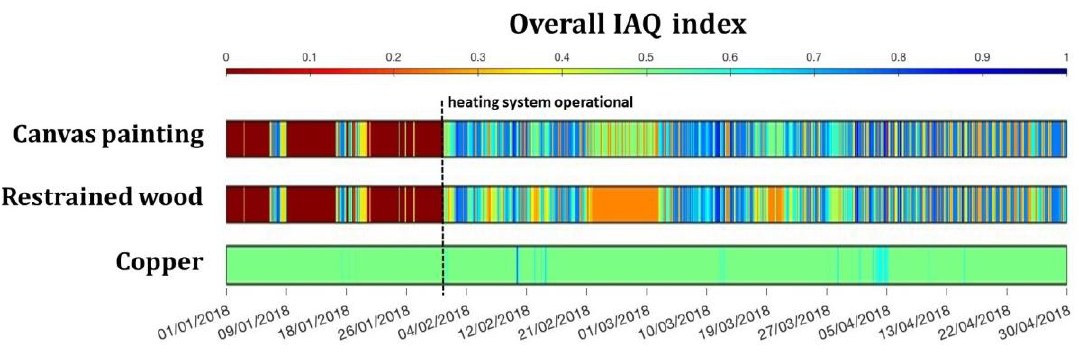
Figure 6. Overall IAQ indexes for canvas painting, restrained wood and copper over a period of 4 months. The dashed line indicates the moment at which the heating system came into operation.